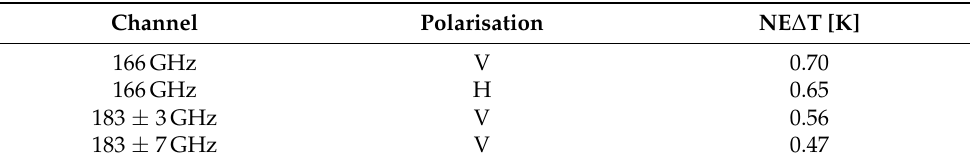
Table 1. The specifications of the Global Precipitation Measurement (GPM) Microwave Imager (GMI) channels that are relevant to this study. V and H denote vertical and horizontal